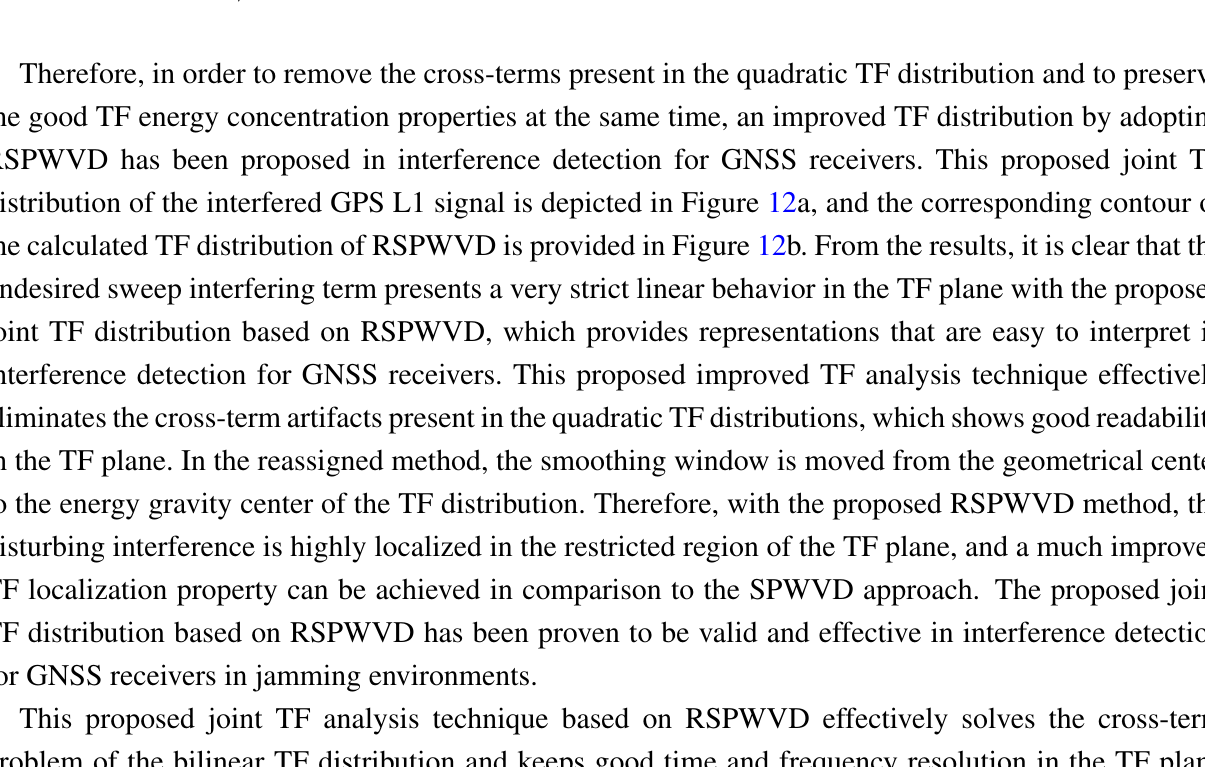
Figure 11. Smoothed pseudo Wigner–Ville distribution of the GPS L1 signal with sweep interference. C/N = 46 dB-Hz, JNR = − 1 0